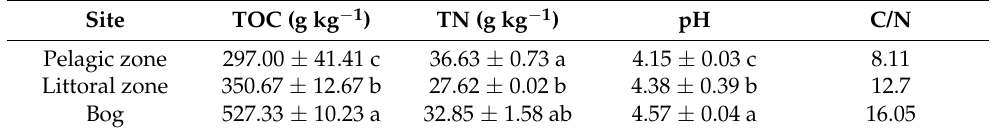
Table 2. Physicochemical properties in the surface sediments/soil (0–20 cm depth) in pelagic zone, littoral zone and bog during the growing